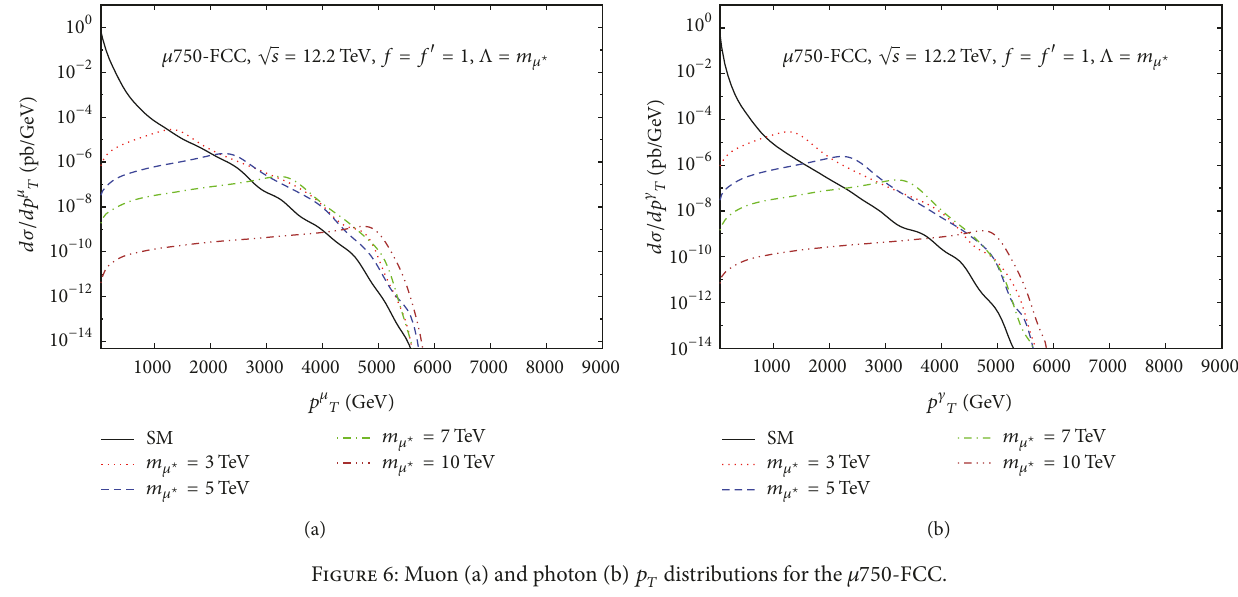
Figure 6: Muon (a) and photon (b) 𝑝 𝑇 distributions for the 𝜇750 -FCC.